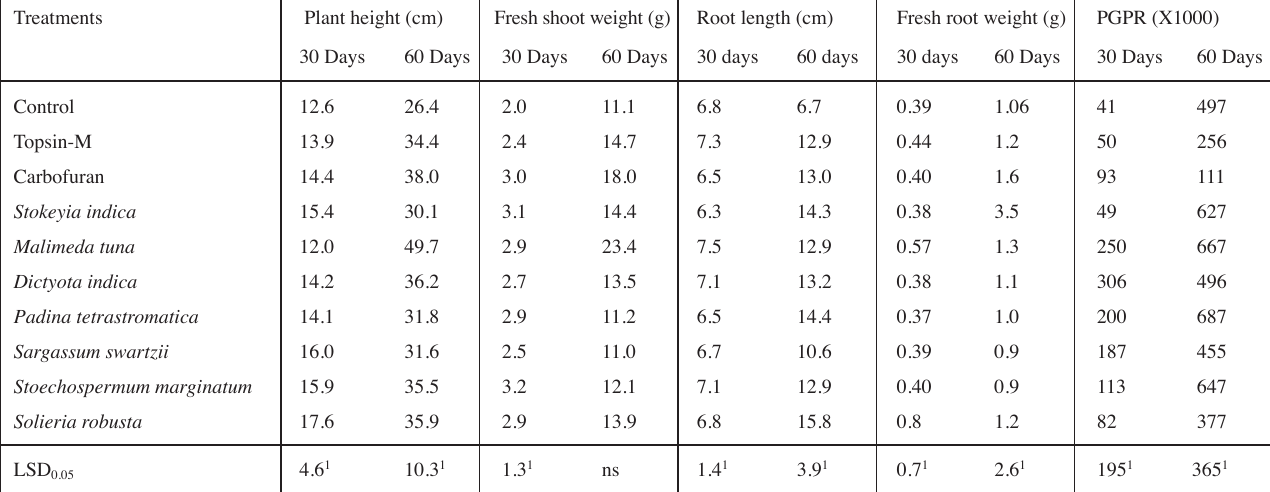
Tab. 4: Effect of seaweeds on the growth of soybean and population of rhizospheric fluorescent Pseudomonas (PGPR) in field experiment. Treatments